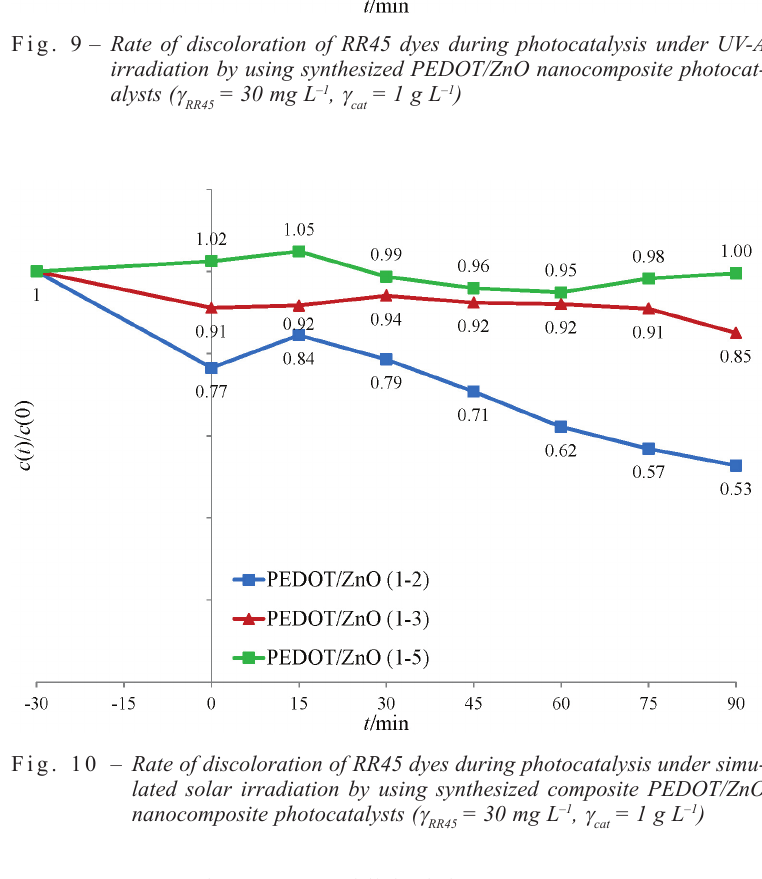
= 30 mg L –1 , g = 1 g L –1 RR45 cat